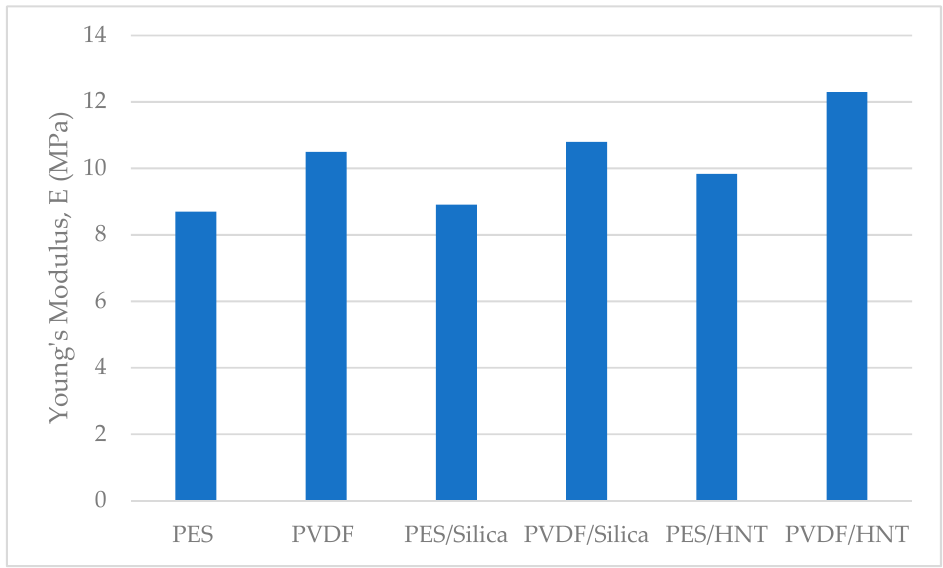
Figure 12. Young’s modulus of pure and nanocomposite membranes.